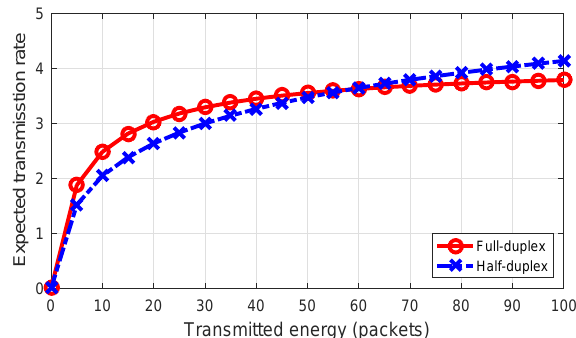
Figure 8. Expected transmission rate based on transmission energy (nats/s/Hz) in the CU when 10 (dB) and χ U = χ B = χ = G U = G D = −